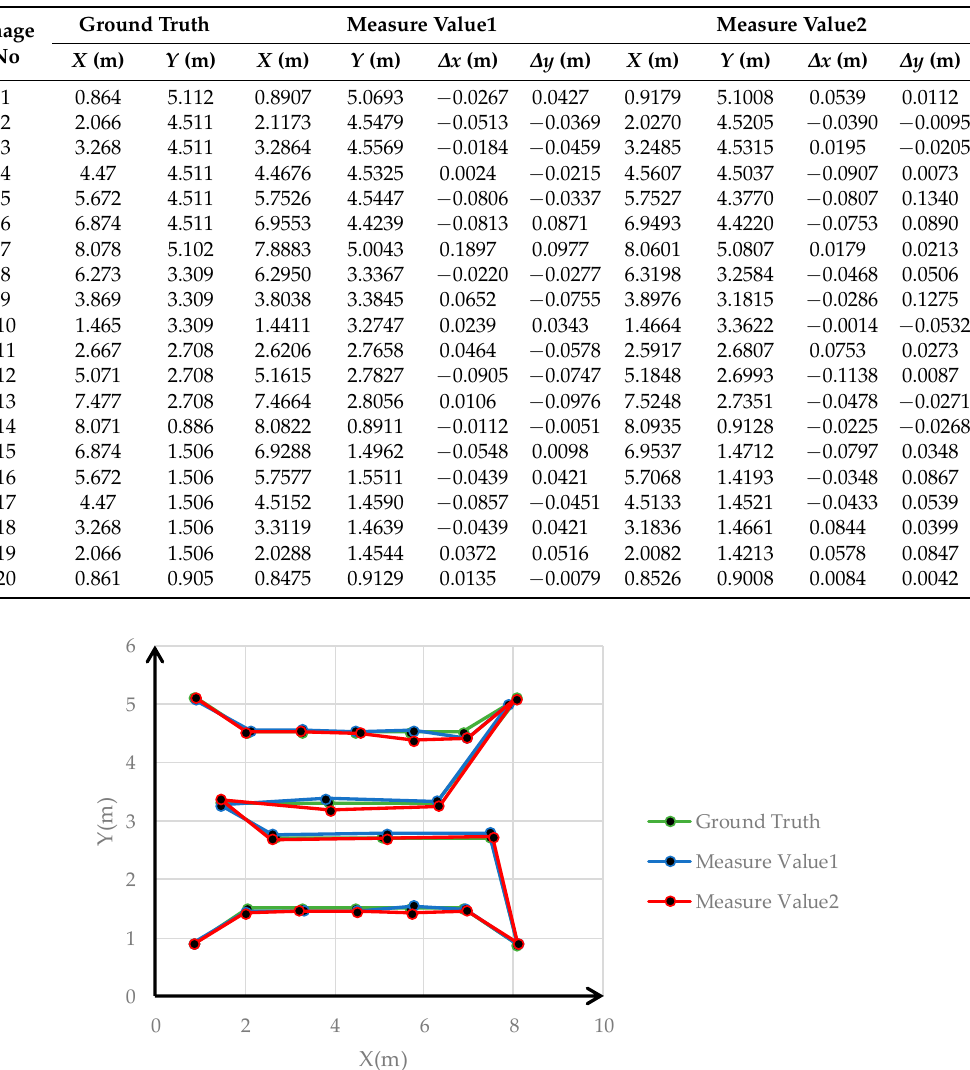
Figure 13. Comparison of two measurements results of the Samsung Galaxy S8 and corresponding ground truth.